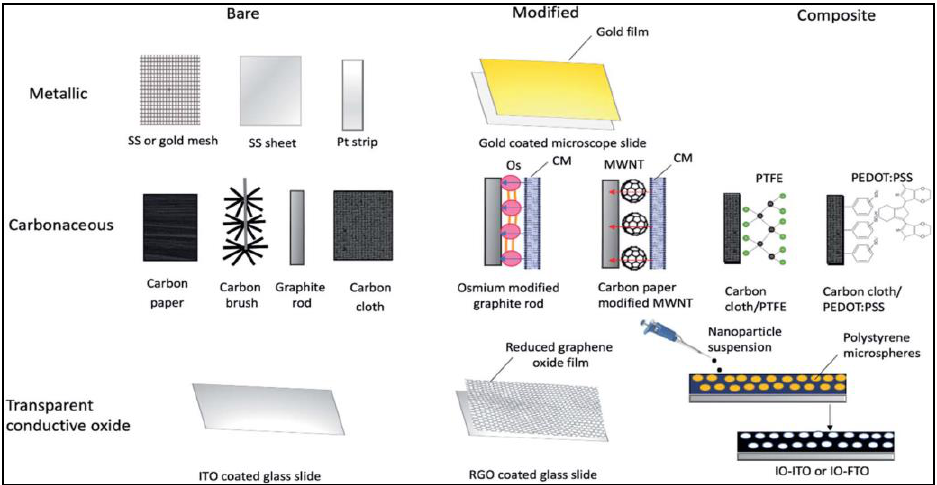
Figure 1. Summary of various electrode configurations used in biophotovoltaic systems. Abbreviation: SS, stainless steel; Pt, platinum; Os, osmium; CM, cytoplasmic membrane; MWNT, multiwalled nanotube; PTFE, polytetrafluoroethylene; PEDOT:PSS, poly(3,4-ethylenedioxythiophene):polystyrene sulfonate; ITO, indium tin oxide; IO-ITO, inverse opal indium tin oxide; IO-FTO, inverse opal fluorine doped tin oxide. Reprinted with permission from Sustainable Energy & Fuels, copyright 2021, Royal Society of Chemistry [1].